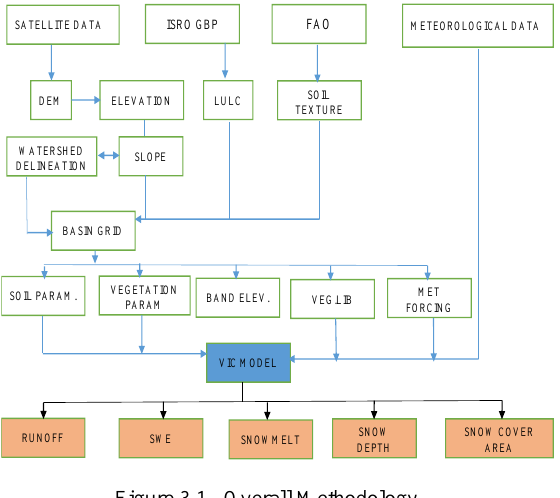
Figure 3.1. Overall Methodology